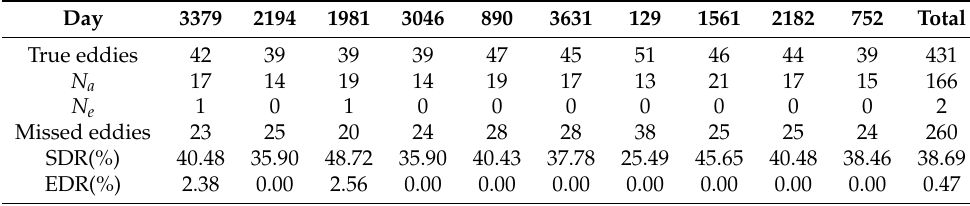
Table 3. VG results for the 10 days used for the validation.